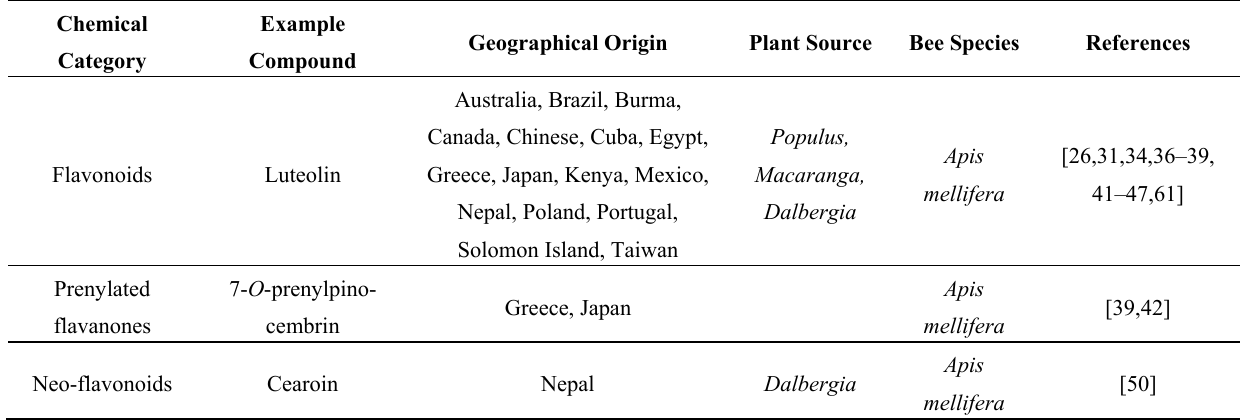
Table 4. The chemical categories reported in propolis since